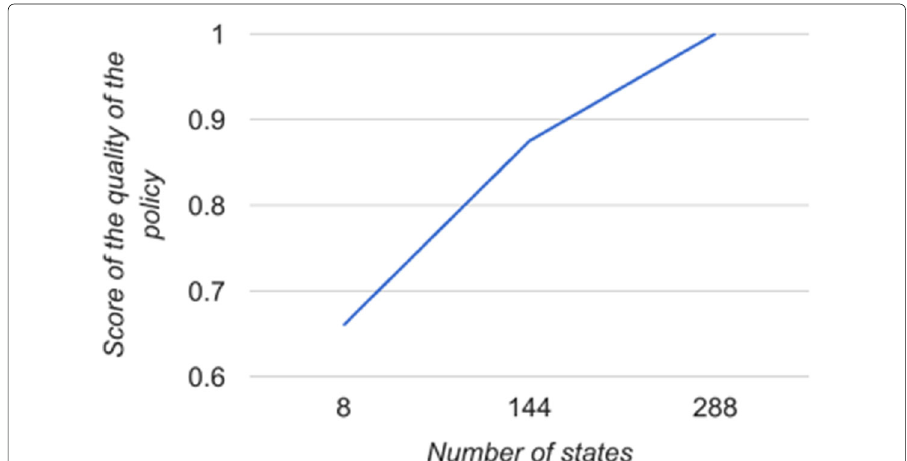
Fig. 3 Score of the quality of the policy by number of states. Figure 3 shows the score of the quality of the policy by the number of states. The quality of the policy is defined by Score = n number of times the wizard followed the agent’s recommendations per dialogue and N the as average of recommendations received per dialogue. The score of the quality of the policy varies between 0 and 1. For the novice agent, the quality of the policy is equivalent to 0.66 and is poor compared to the intermediate agent (0.875) and the advanced agent (1)